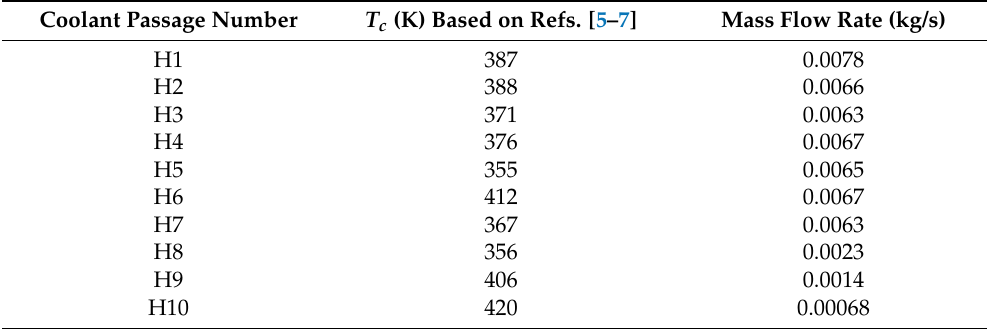
Table 4. Boundary conditions of the internal coolant passages.